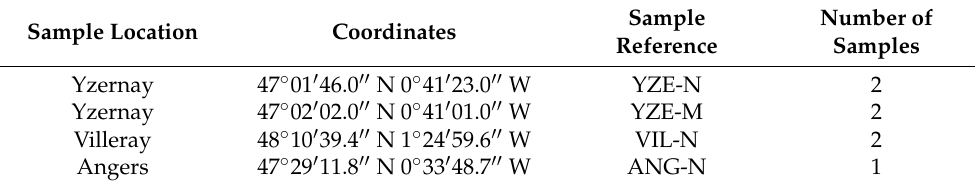
Table 3. Location and reference of each